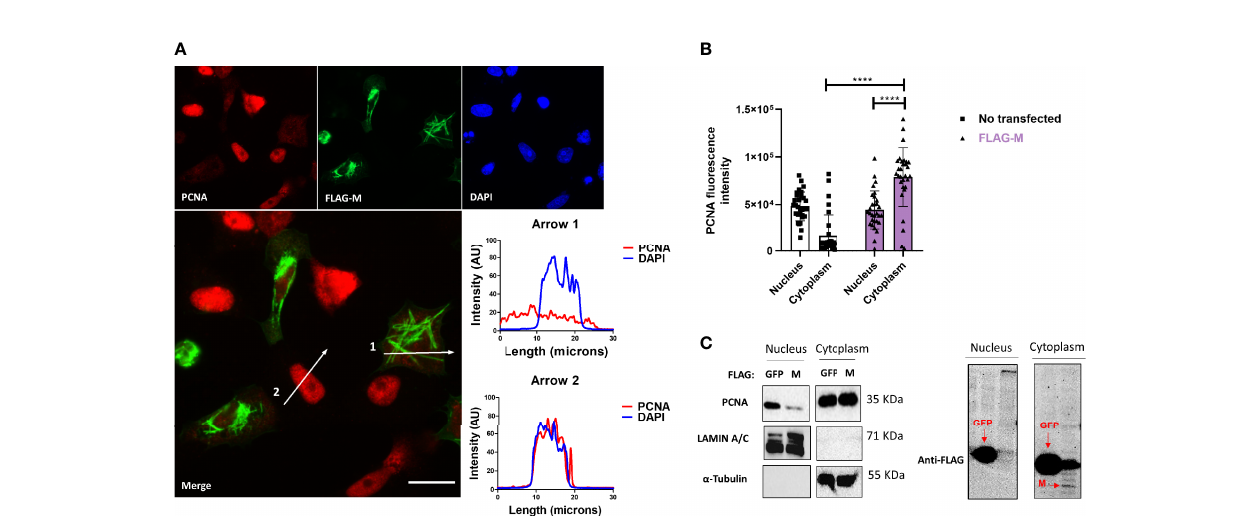
FIGURE 2 | FLAG-M expression promotes PCNA translocation to cytoplasm. (A) Vero E6 cells expressing FLAG-M protein, 24h after transfection, were fi xed and stained for FLAG-M (green), PCNA (red), and DAPI. Graphs show plot pro fi le intensities for PCNA and DAPI channels in the cross-sections indicated by arrows 1 and 2. Images are representative of two independent experiments. Scale bar 20 m m. (B) PCNA localization was analyzed through fl uorescence intensity in non- transfected and FLAG-M transfected cells. Brie fl y, the nuclei area stained with DAPI was selected manually and the ROI (region of interest) obtained was used to measure PCNA intensities on nucleus and cytoplasm. Fluorescence intensity was quanti fi ed in grayscale on ImageJ. This data is representative of two independent experiments. The data represent mean ± SD (n=30). For statistical analysis, Two-way ANOVA and multiple comparison Bonferroni ’ s tests were used. ****p < 0.0001 were considered statistically signi fi cant. (C) Vero E6 cells were transfected with vectors to express FLAG-tagged M or GFP proteins, and after 48 hours cellular fractionation followed by Western blotting was performed. LAMIN A/C and a -Tubulin proteins were used as controls for nuclear and cytosolic fractions, respectively. The expression of the transfected proteins is shown in the right panel. Western blot images are representative of one independent